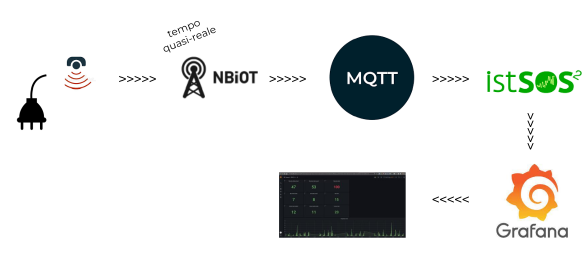
Figure 3. Data flux and adopted technological components. Parco del Penz